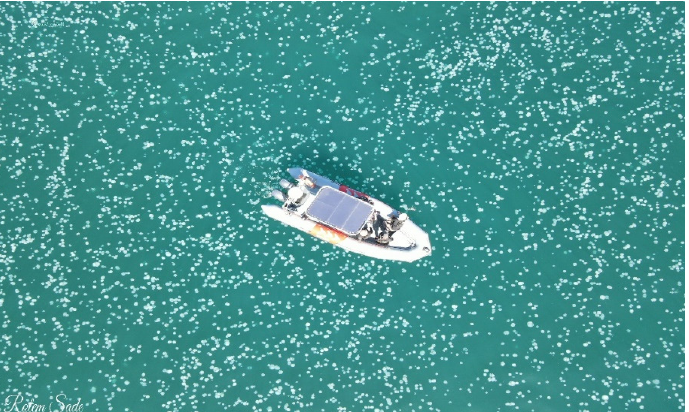
Figure 17. A huge swarm of the invasive nomadic jellyfish, Rhopilema nomadica , in the Bay of Haifa, July 2022 (drone photography by Rotem Sade).